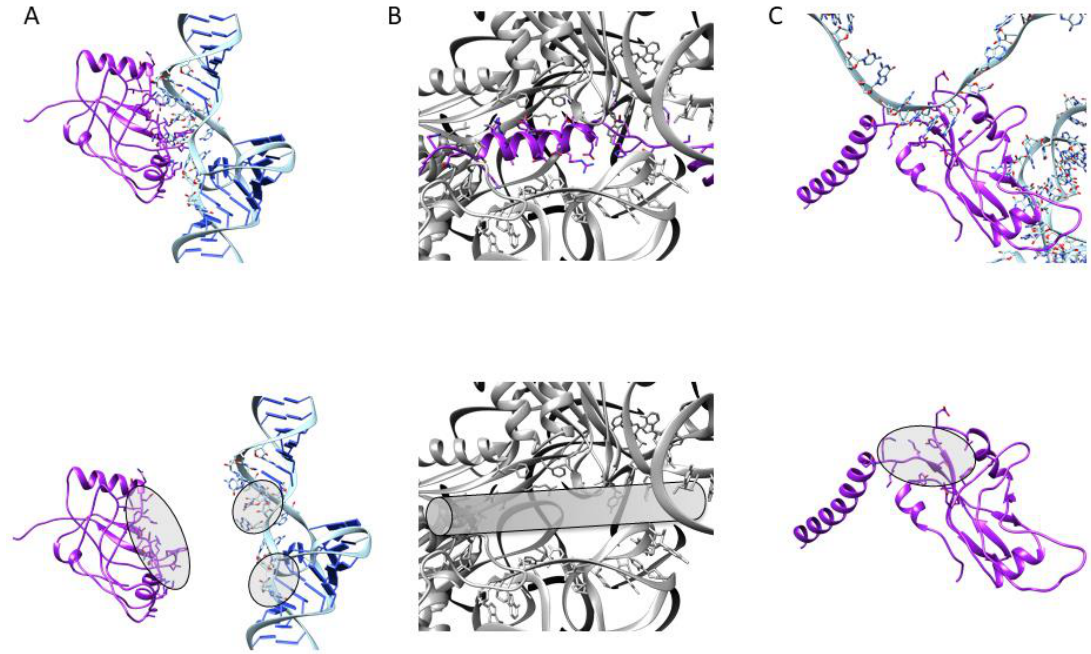
Figure 5. Potential anti- trans -translation targets. To interfere with trans -translation, one can ( A ) inhibit the tmRNA–SmpB interaction by targeting the binding sites of either partner; ( B ) compete with the SmpB C-terminal tail for stalled ribosome recognition; ( C ) alter the tagging process by targeting the binding site between SmpB and the